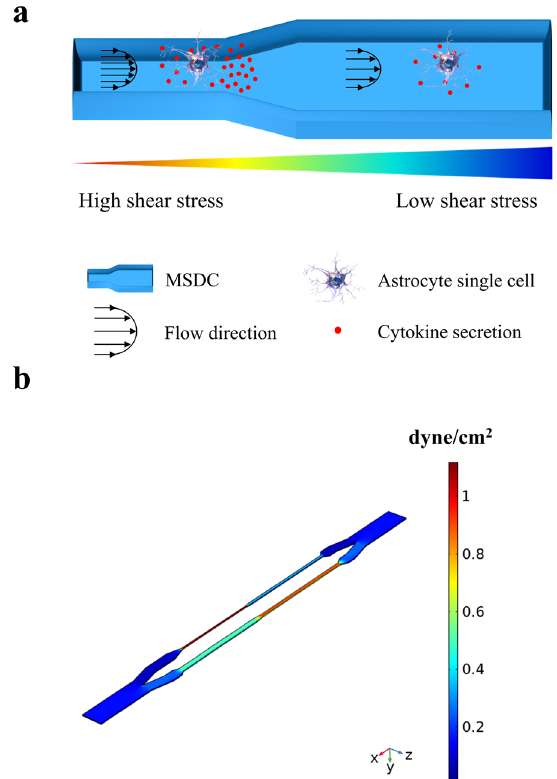
Fig. 2 Multiplex high-throughput micro fl uidic device for uniform shear stress stimulation of cells. a Schematic of the MSDC design with different widths to provide a multiplex culture platform to measure different shear stress stimulations on cells. The microchannel with a smaller width and a higher fl uid fl ow shear stress presents higher cytokine secretion from cells. b COMSOL simulations of fl ow in the microchannels predicted relatively uniform wall shear stress values across cell adhesion areas for all TIR-FM analysis. A fl ow rate of about 10 µ l/min generates more than 0.5 dyne/cm 2 of uniform wall shear stress across the widest rectangular microchannel ’ s surface of 1000 µ m width.